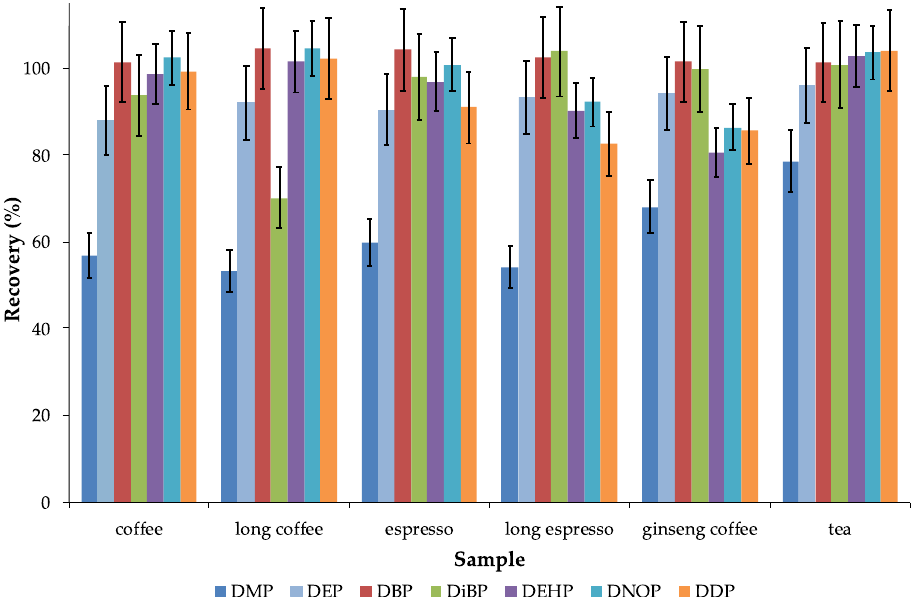
Figure 2. Recovery (%) of each PAE in relation to the matrix effect. The bars represent the standard deviation of each measure. For PAE acronyms: see Table 1.